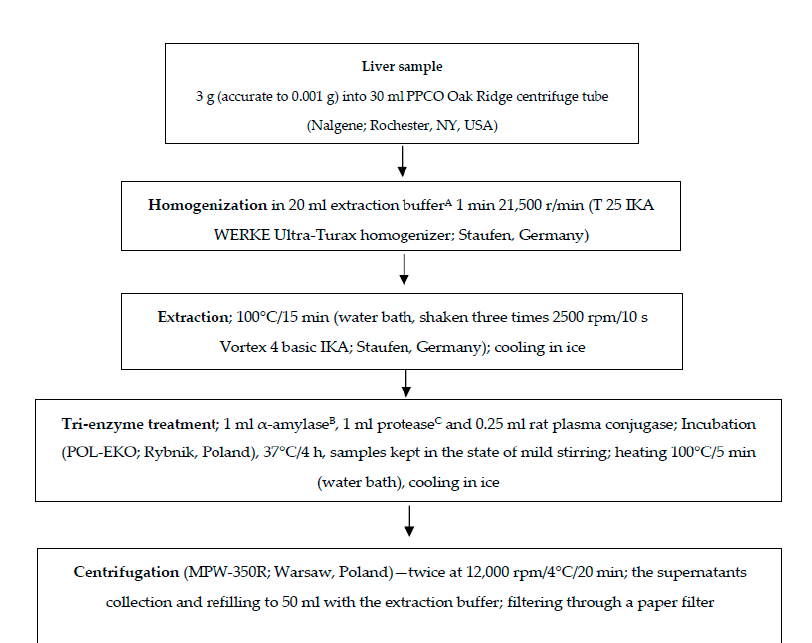
Figure 1. The sample preparation flow chart; A extraction buffer: 0.1 M phosphate buffer pH 6.1 with 1% ( w / v ) sodium ascorbate and 0.1% ( v / v ) 2-mercaptoethanol; B 1 ml α -amylase solution (20 mg/mL);